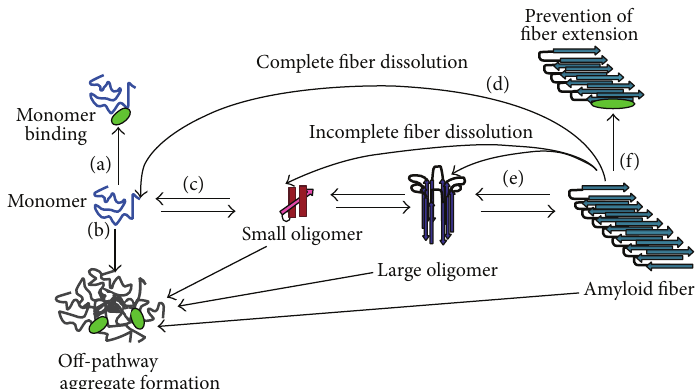
Figure 3: Possible influences of ligands on hIAPP aggregation. Schematic illustrating some of the possible mechanisms by which an inhibitor can affect aggregation: (a) monomer stabilization; (b) stabilization of off-pathway intermediates; (d and e) dissolution of fibers either completely to the monomeric state (d) or incompletely to another oligomeric form (e); (f) prevention of fiber extension. Note that this is not an exhaustive list of possible